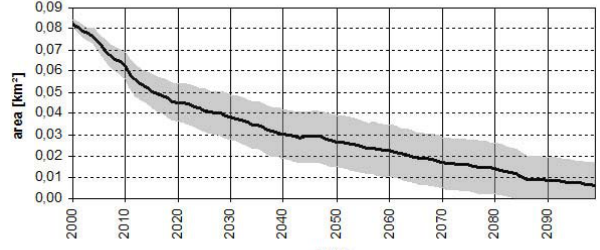
Fig. 8. Surface mass balance evolution of Martial Este Glacier